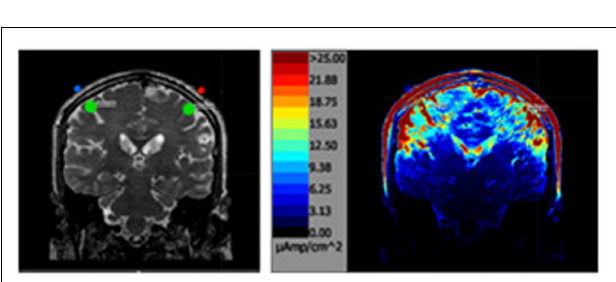
FIGURE 1 |Above are illustrations of the large and small electrodes placed on the head by the 10–10 software .The large electrode is 50mm × 45mm the small electrode is 20mm diameter.